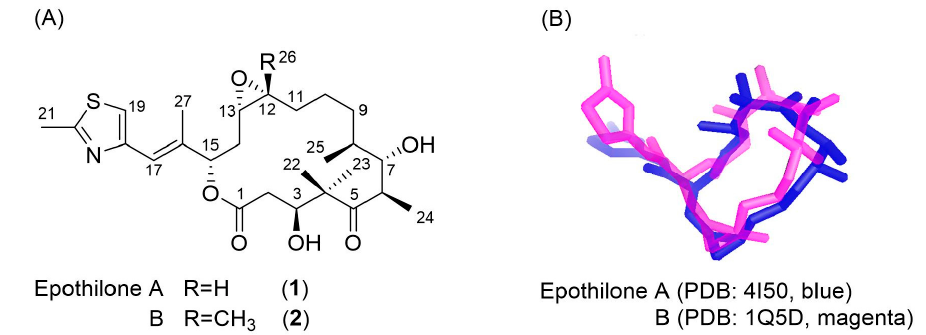
Figure 1. ( A ) The chemical structures of epothilone A and B; ( B ) The binding modes of epothilone A (PDB 4I50, blue) and B (PDB 1Q5D, magenta), the spatial coordinates being arbitrary and three-dimensionally rotated for the two conformations to overlap.